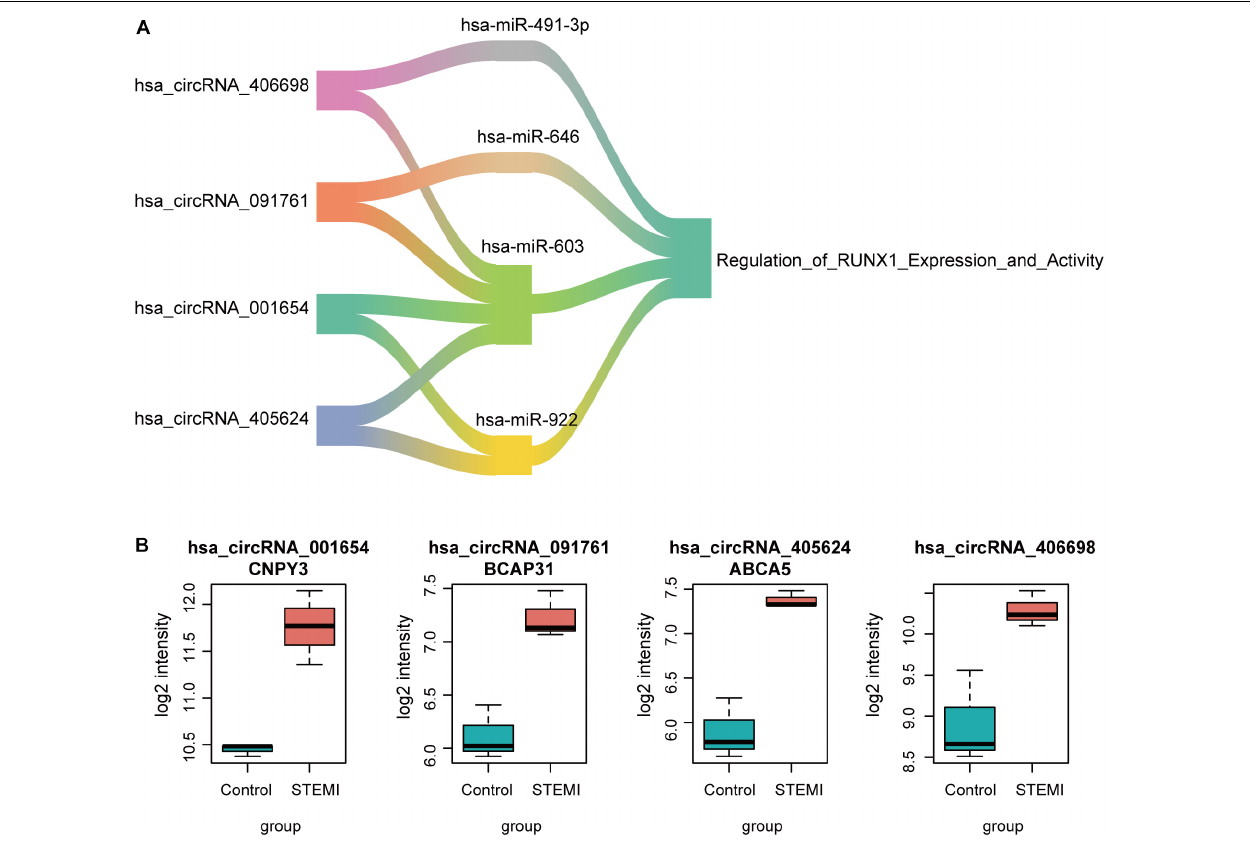
FIGURE 4 | CircRNA-miRNA networks involved in RUNX1 regulation. (A) Interaction networks between targeted miRNAs in the regulation of RUNX1 and circRNAs. (B) Expressions of four candidate circRNAs in AMI and ctrl.